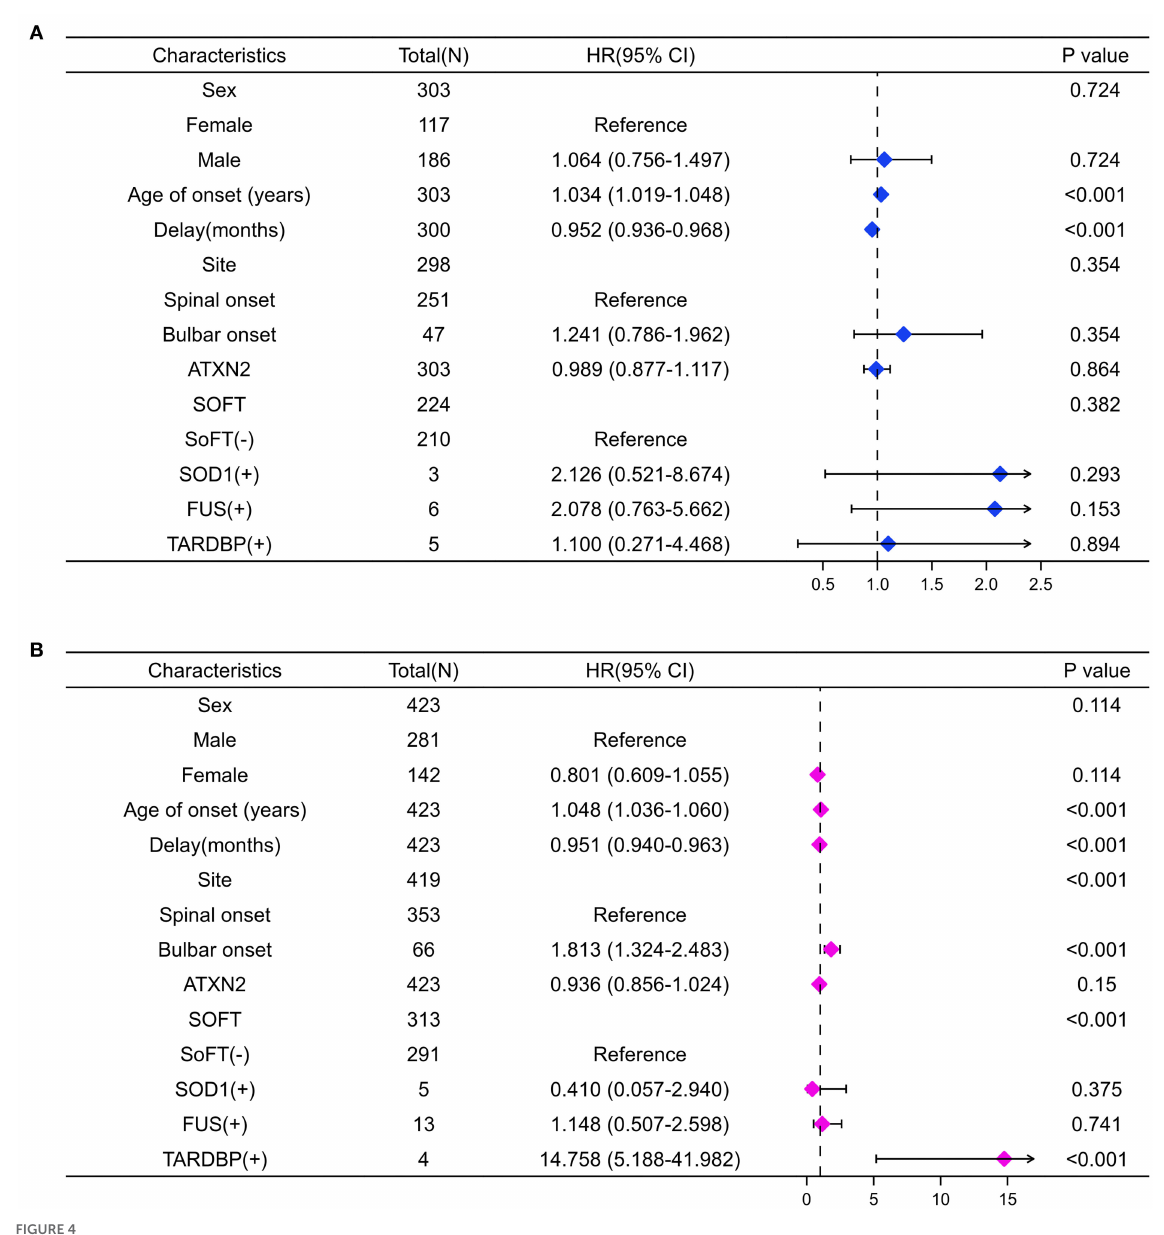
of SQSTM1/p62 involved in macroautophagy/autophagy and phosphorylated TDP-43 (16). C9orf72 reduction alone, however, did not trigger major neuronal toxicity, suggesting that extra stress is probably required to induce neuronal death upon C9orf72 loss of function. We, therefore, hypothesized that additional pathological mutations may affect the survival of patients carrying C9orf72 repeats of 2 and our finding (4 patients with repeats > 2 vs. 5 patients = 2, 16.3 vs. 58.1